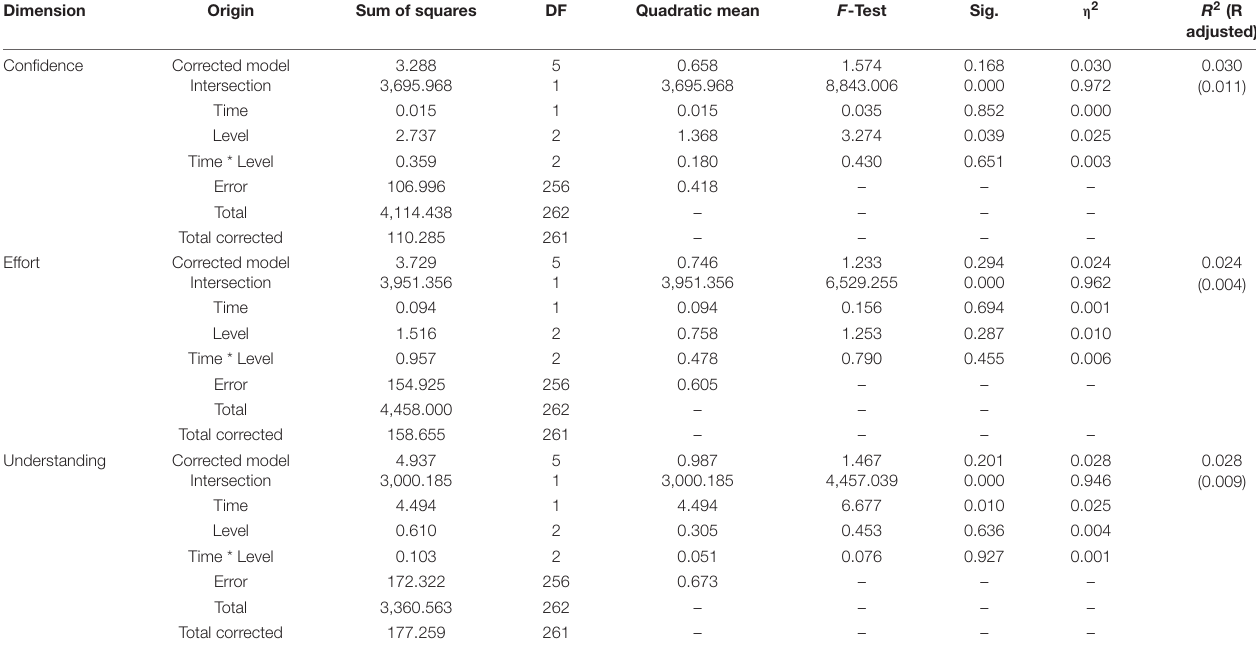
TABLE 3 | Model fit by dimension.